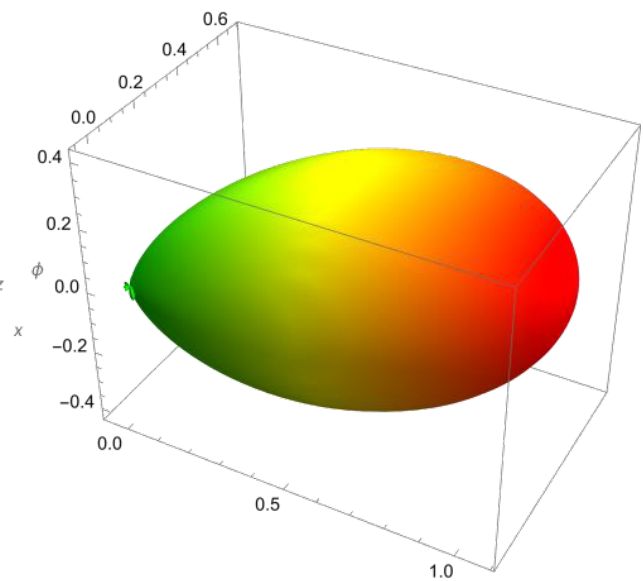
Figure 7. Three-dimensional view of the single beam formed at 30 ◦ when the transmitter antenna elements are half-wave dipoles.